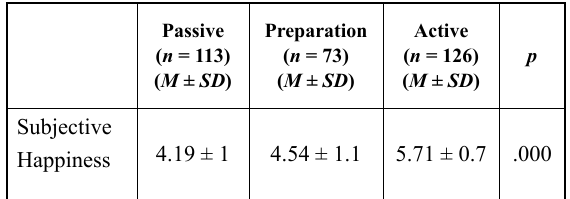
Table 1b. The distribution of SHS scores according to stages